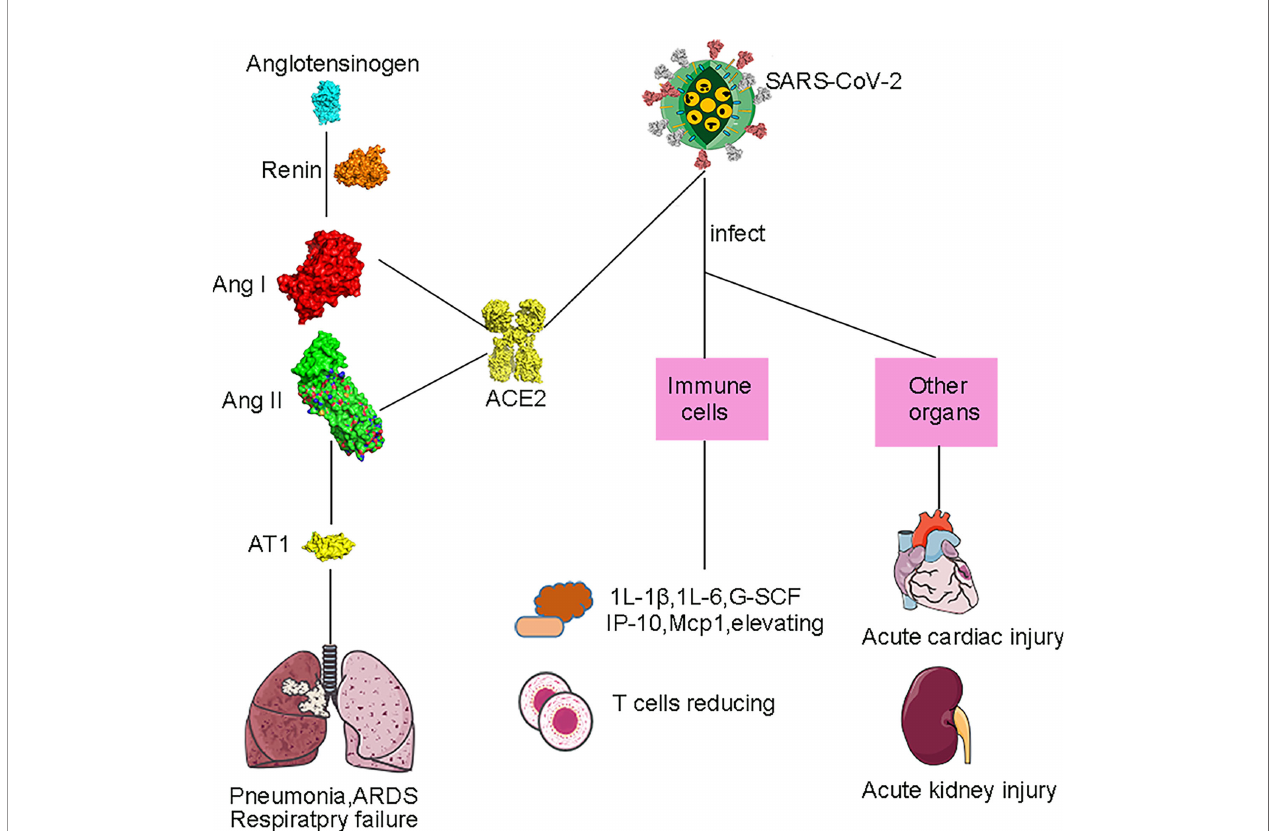
FIGURE 4 | Pathogenesis of SARS-CoV-2. By inhibiting the ACE2 ’ s function, SARS-CoV-2 could cause the injury of the lung. ACE2 plays an important role in the renin-angiotensin system (RAS). Firstly, renin converts angiotensinogen into angiotensin I (AngI), and then AngI is converted into AngII under the ACE2 ’ s action. ACE2 down-regulates the AngI ’ s and Ang II ’ s levels. Then, the Ang II type I (AT1) receptors are bound by Ang II, causing lung injury, which includes acute lung injury, pulmonary fi brosis, and pulmonary hypertension. At the same time, Ang II can directly induce rapid growth or proliferation of pulmonary artery smooth muscle cells through AT1, thereby causing pulmonary hypertension. Besides the intestines and lungs, the heart, kidney, esophagus, bladder, ileum, testis, and adipose tissue also could express ACE2, and its level is higher than that of the lung. In addition, tumor tissues have high ACE2 expression, making cancer patients more vulnerable than